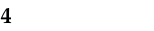
Table 5. Pattern matrix of CECVS—committing cyber-violence subscale.